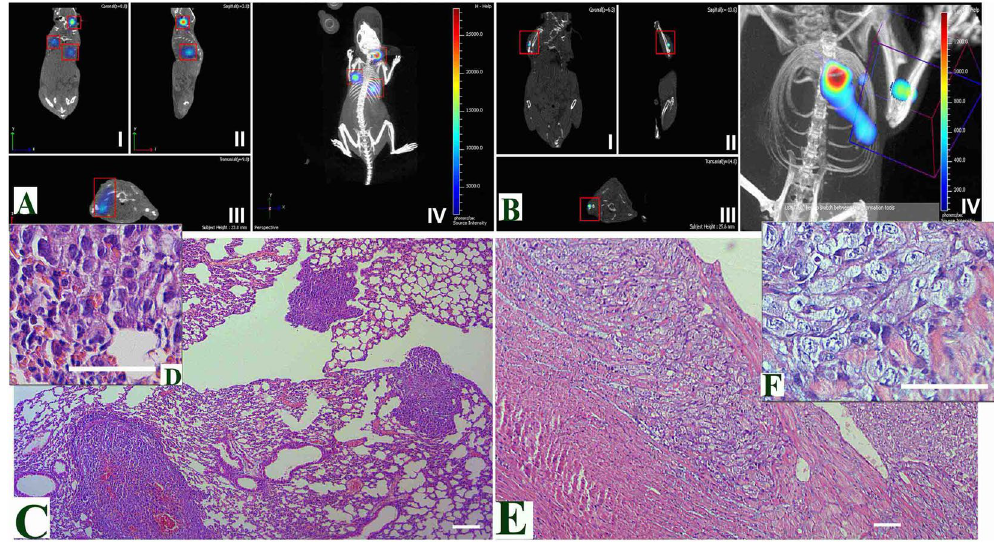
Figure 5. Characteristics of the metastatic potential of Luc-expressing 4T1 cells in the orthotopic breast cancer model evaluated by BLI and confirmed by MRI. Small metastases of 4T1luc2D6 cells in the lungs and soft tissues one week after removal of the primary focus (week 4 after the implantation of 4T1lucD6 cells) visualized by micro-CT, 3D BLI ( A , B ), and verified by histochemistry ( C , D , E , F ). Metastasis as a single source of luminescence are detectable in the lung and neck ( A ), and in the lung and muscle tissues of the lower right foreleg ( B ), panels I, II, III demonstrate microCT xy-, yz-, and zx- projections respectively, and panel IV, 3D reconstruction of microCT and BLI ( A , B ); Histological verification of the multiple 200–500 μ m metastasis in lungs ( C , D ), and muscle tissues ( E , F ); Metastases in muscle tissue, 300 × 600 μ m in size, detected by bioluminescence imaging ( E ). Hematoxylin-eosin staining of sections of paraffin-block preparations of the lung metastases ( C , D ) and metastases in muscle tissue ( E , F ) demonstrated hypercellular foci consisting of the polymorphic cells characteristic of the high-grade carcinomas. Magnification 50 × ( C , E ) and 200 × ( D , F ); scale bar 50 μ m.